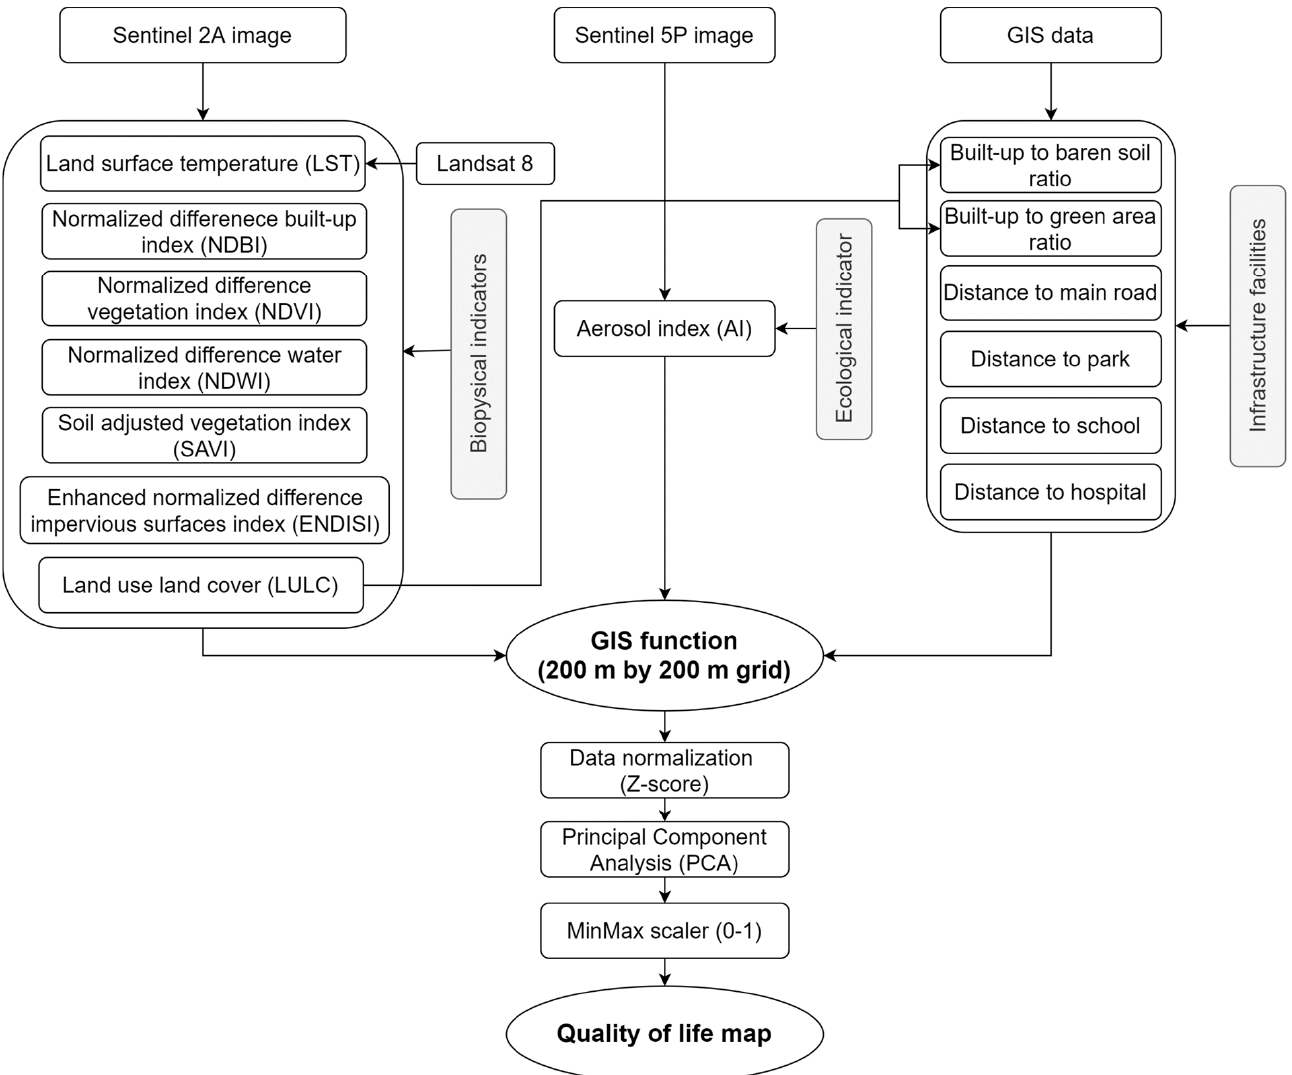
Figure 2. A flowchart of developing UQoL model for the study area. Table 1. Urban quality of life indicators extracted from remote sensing and GIS vector data.